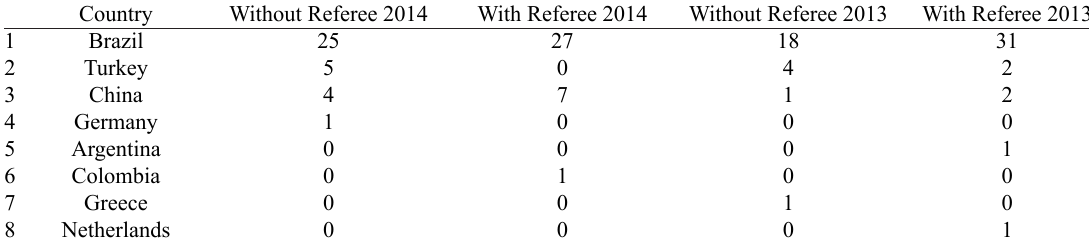
Table 4. Countries of origin of the manuscripts rejected by the Brazilian Journal of Cardiovascular Surgery in 2013 and